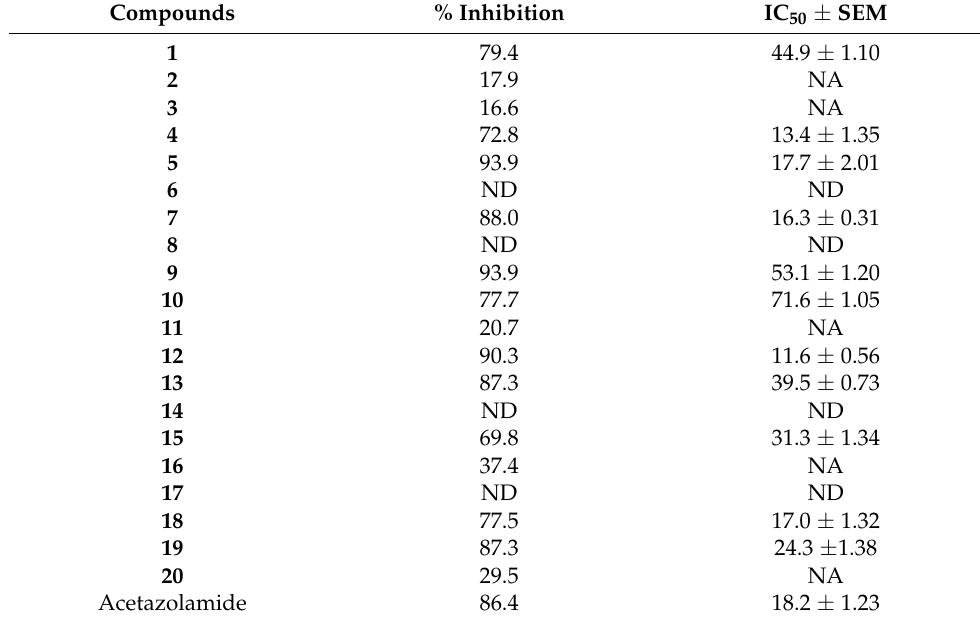
Table 1. The carbonic anhydrase-II inhibitory activities of the isolated compounds.